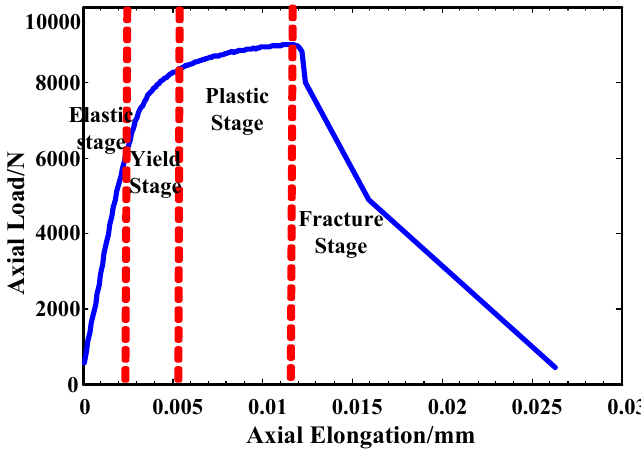
Figure 1. The axial load-axial elongation curve and four stages of tensile